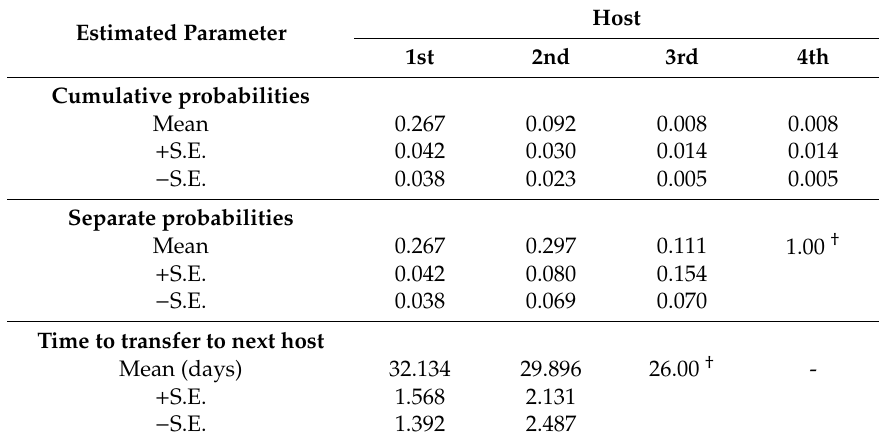
Table 2. Probabilities of reproductive success on successive hosts by individual Sclerodermus brevicornis females and the timing of transfer between